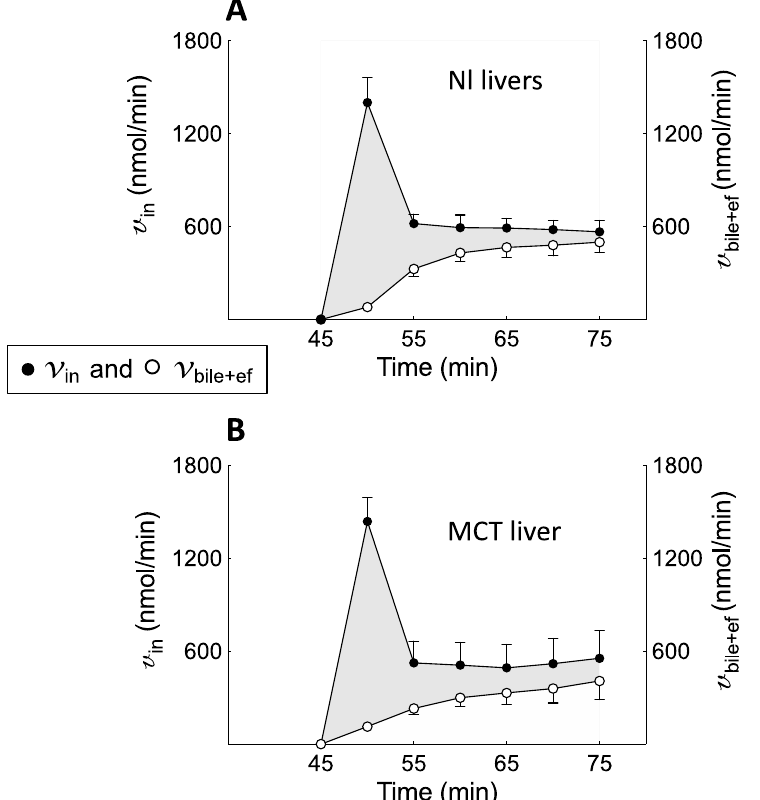
excretion rates ( v bile ) over time were significantly lower in MCT than in Nl liver ( p < 0.0001, Table 1). In contrast, efflux rates into sinusoids ( v ef ) were significantly higher in MCT than in Nl livers ( p < 0.0001, Table 1). In both groups, influx rates were higher than total efflux rates (Figure 4, grey area), and the difference was low at the end of the perfusion period.